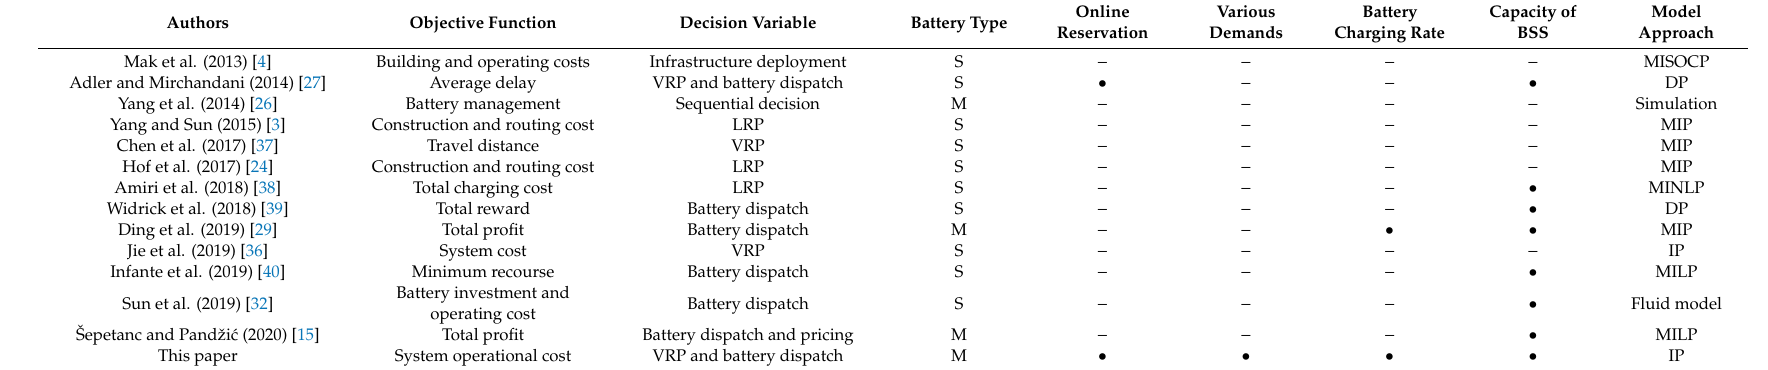
Table 3. Comparison between existing related SC models and our model